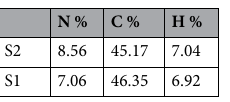
Table 4. Elemental analysis of the nitrogen-rich